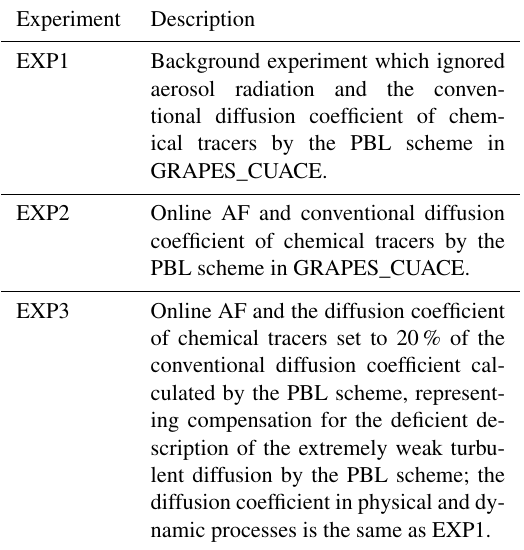
Table 3. Design of sensitivity experiments.